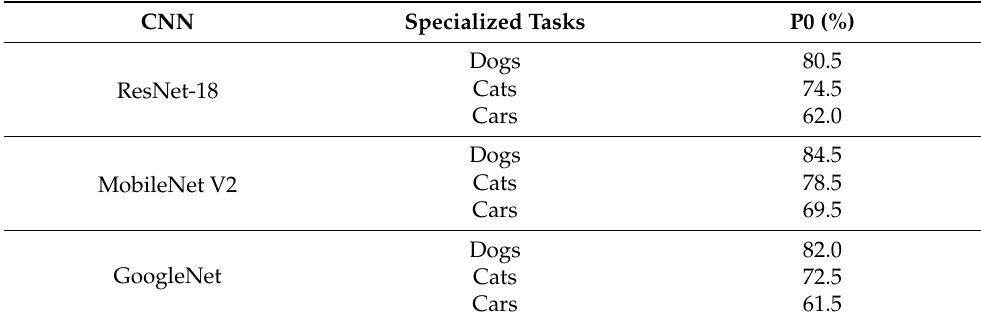
Table 2. Prediction accuracy (P0) achieved by the compressed model with no degradation relative to the uncompressed